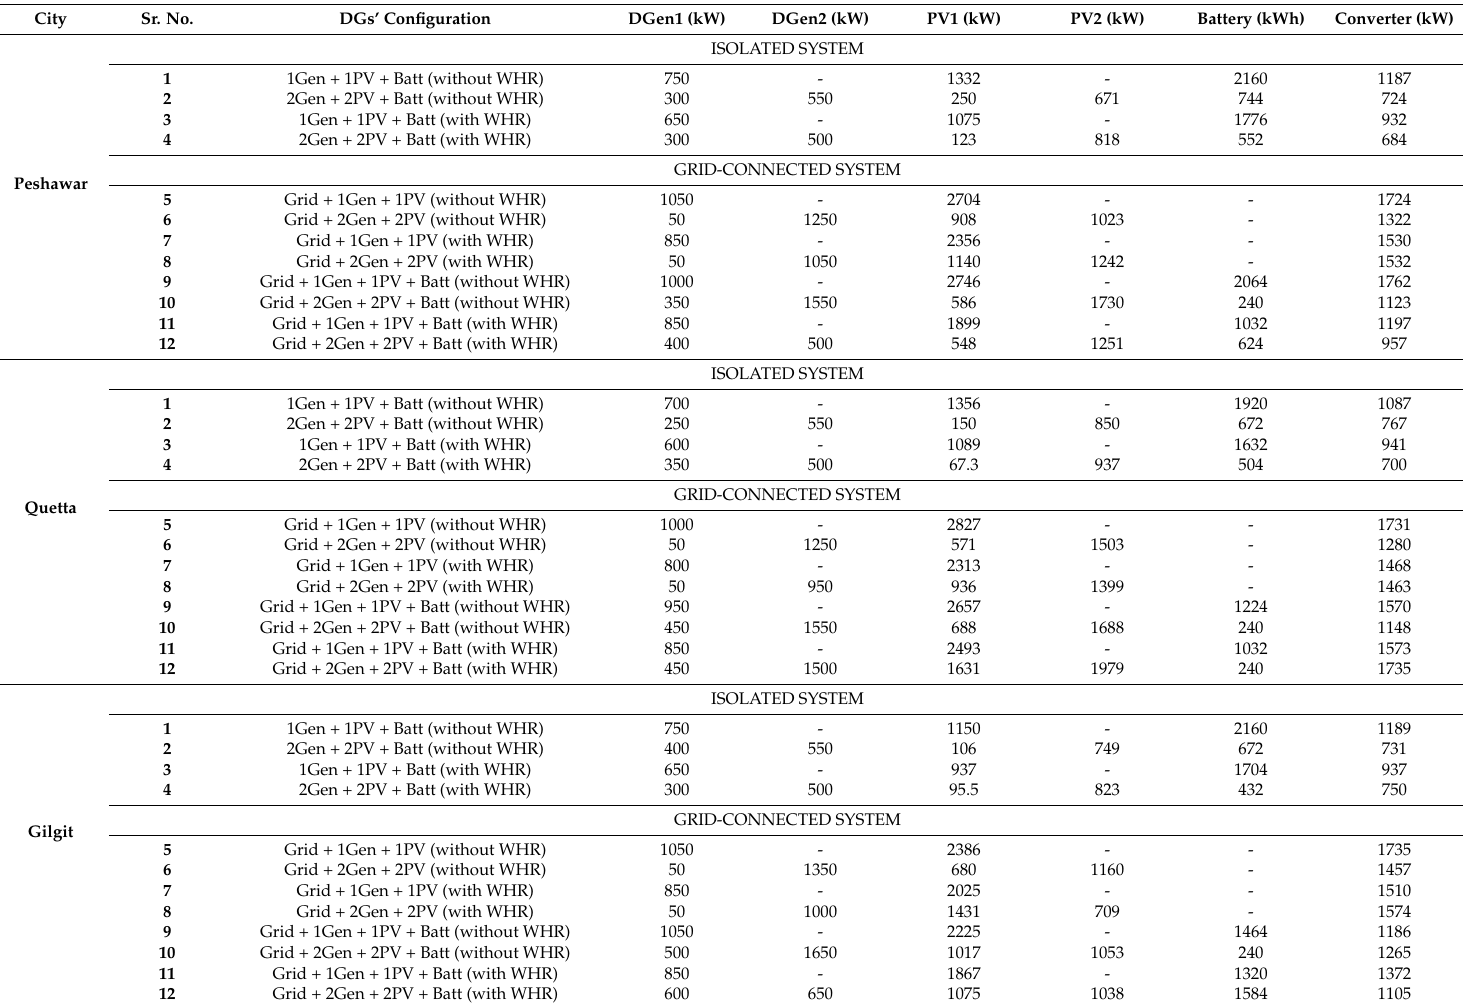
Table 5. Optimal configurations for Peshawar, Quetta and